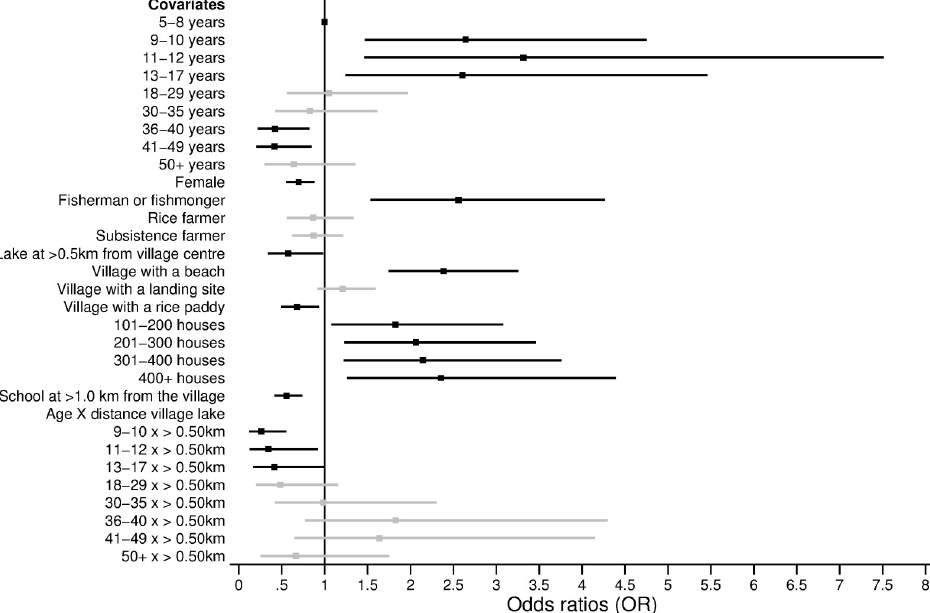
Fig 3. Predictors and modifiers of S . mansoni age-related infection status. Odds ratios (OR) are shown with the corresponding 95% confidence intervals (CI) from the logistic regression model presented in S5 Table in S1 File. Only covariates that were chosen through likelihood ratio tests are shown in the figure. The black squares (lines) represent the OR (95% CI) for the statistically significant covariates (p-value � 0.05). The grey squares (lines) represent the OR (95% CI) for the non-statistically significant (p-value > 0.05) covariates.